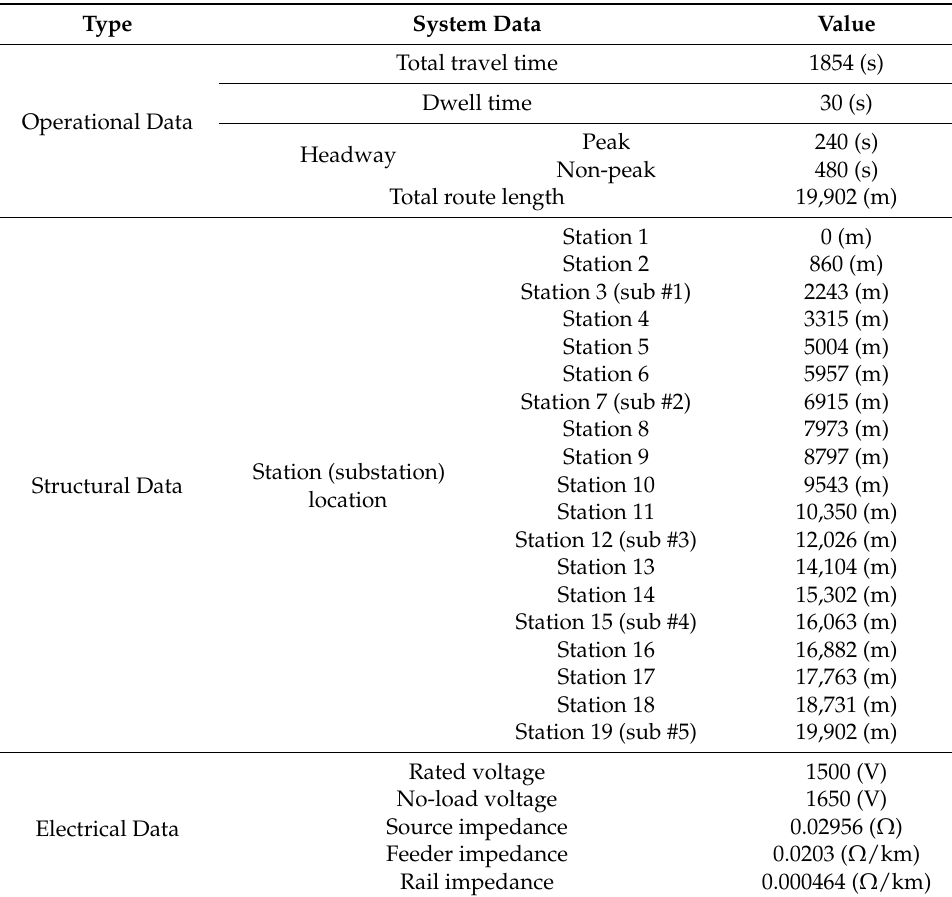
Table 1. System data of the Seoul Metro